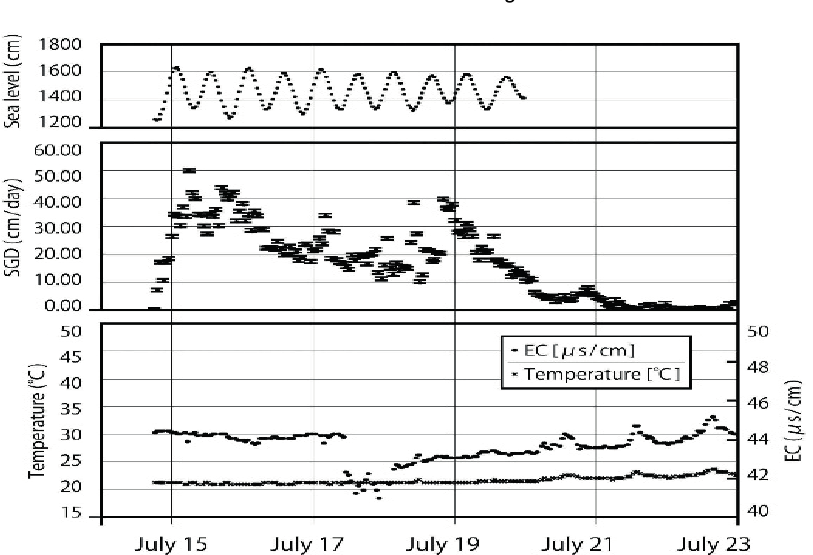
Fig. 2 Temporal changes in sea level, SGD, temperature and electrical conductivity (EC) at Kawarazu.